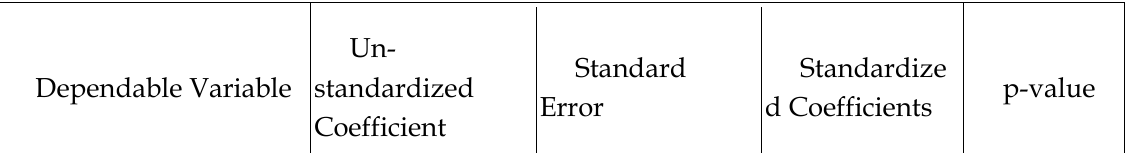
Table 3: Empirical